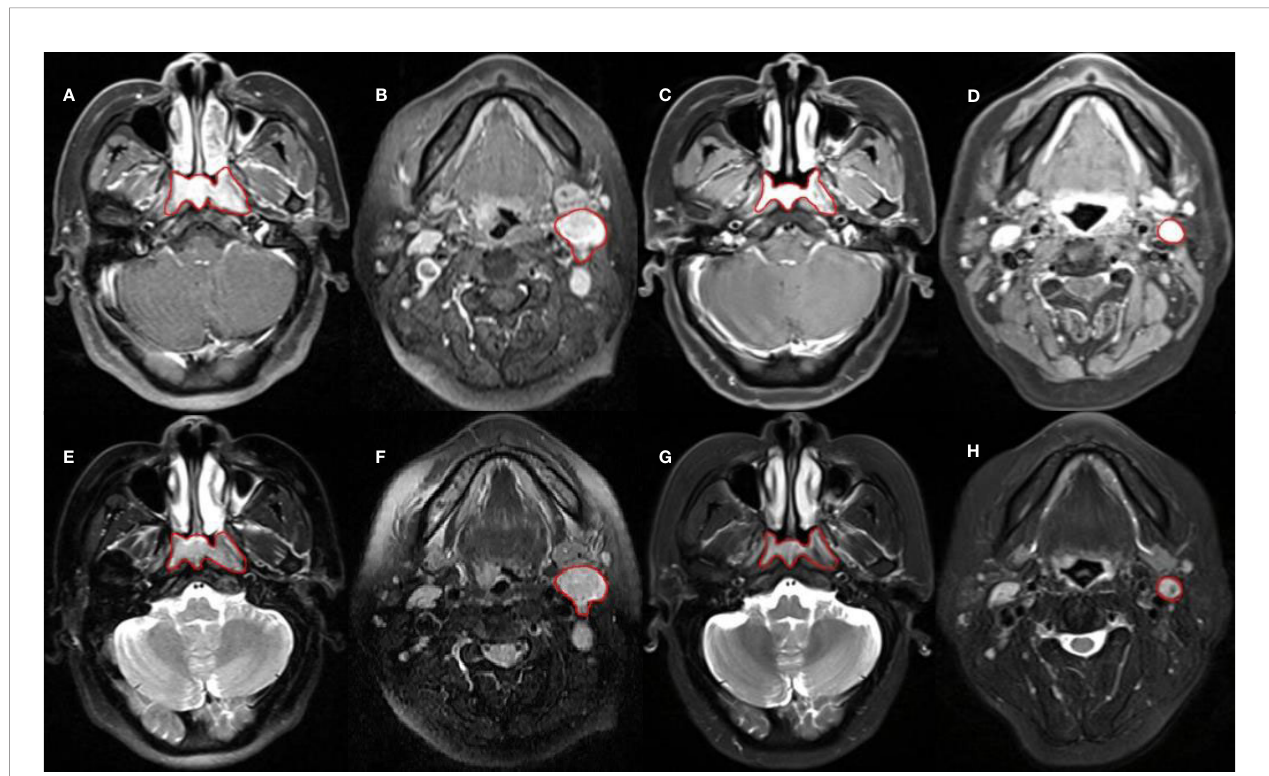
FIGURE 1 | Sketch of ROI. (A – D) are CET1WI sequences; from left to right, they are GTVnx and GTVln in pre-treatment, GTVnx and GTVln in mid-treatment. (E – H) are T2WI sequences; from left to right, they are GTVnx and GTVln in pre-treatment, GTVnx and GTVln in